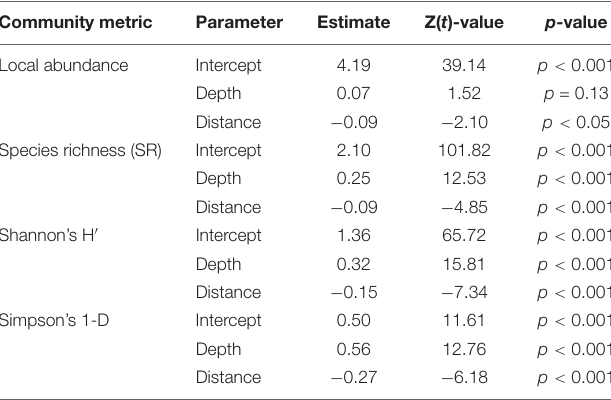
TABLE 2 | Generalized Linear Mixed Models (GLMMs) parameter estimates for four community metrics: local abundance of organisms, species richness (SR), Shannon’s diversity index (H (cid:48) ), and Simpson’s diversity index (1-D). Community